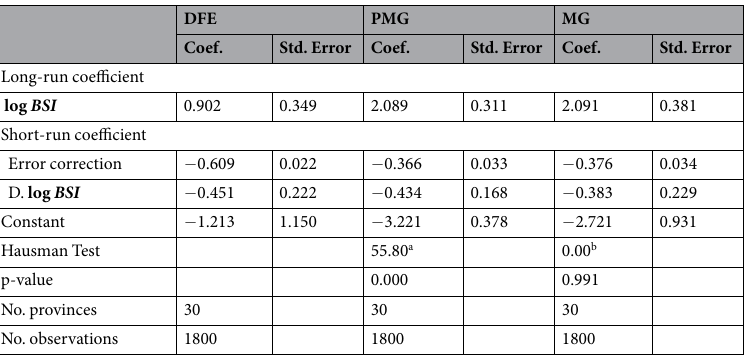
Table 2. Long- and short-run association of HIV/AIDS BSI and HIV/AIDS incidence. (a) Hausman h-test of DFE and PMG estimator; (b) Hausman h-test of PMG and MG